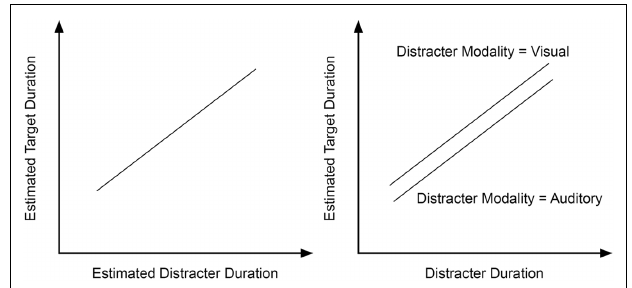
FIGURE 1 | Illustration of the hypotheses of this study. Left panel: Illustration of Hypothesis 1 which states that estimated target duration grows proportionally with estimated distracter duration; right panel: Illustration of Hypothesis 2 which asserts that estimated target duration grows proportionally with the announced distracter duration, but is longer in case of a visual distracter stimulus than in case of an auditory distracter